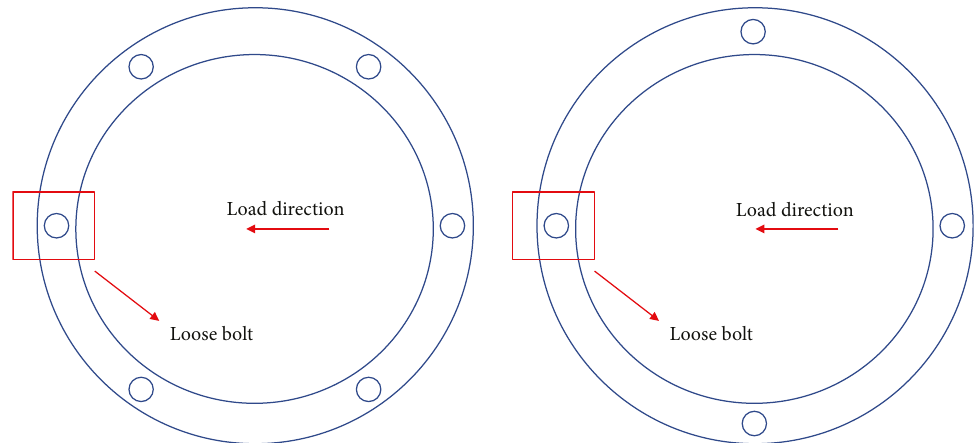
Figure 26: Schematic diagram of bolts arrangement in Tables 1 and 2.